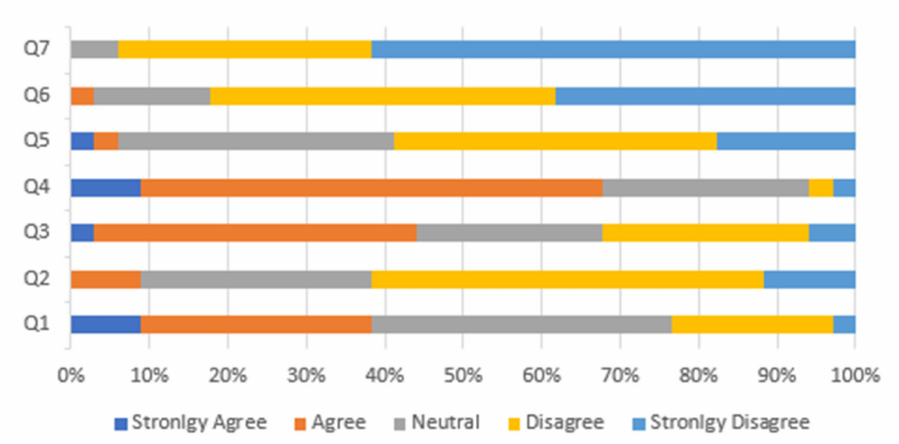
Figure 1. Satisfaction levels to as-built